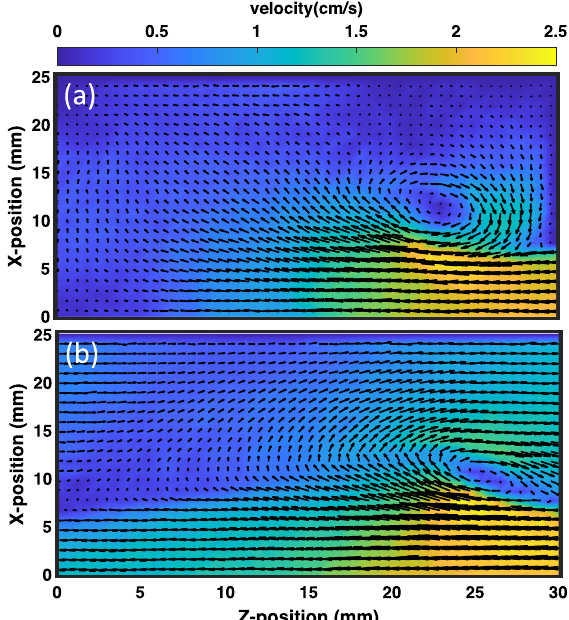
Figure 9. The velocity vector field along with the magnitude of the velocity (cm/s) for ( a ) single-layer flow and ( b ) double-layer flow, which are obtained from the